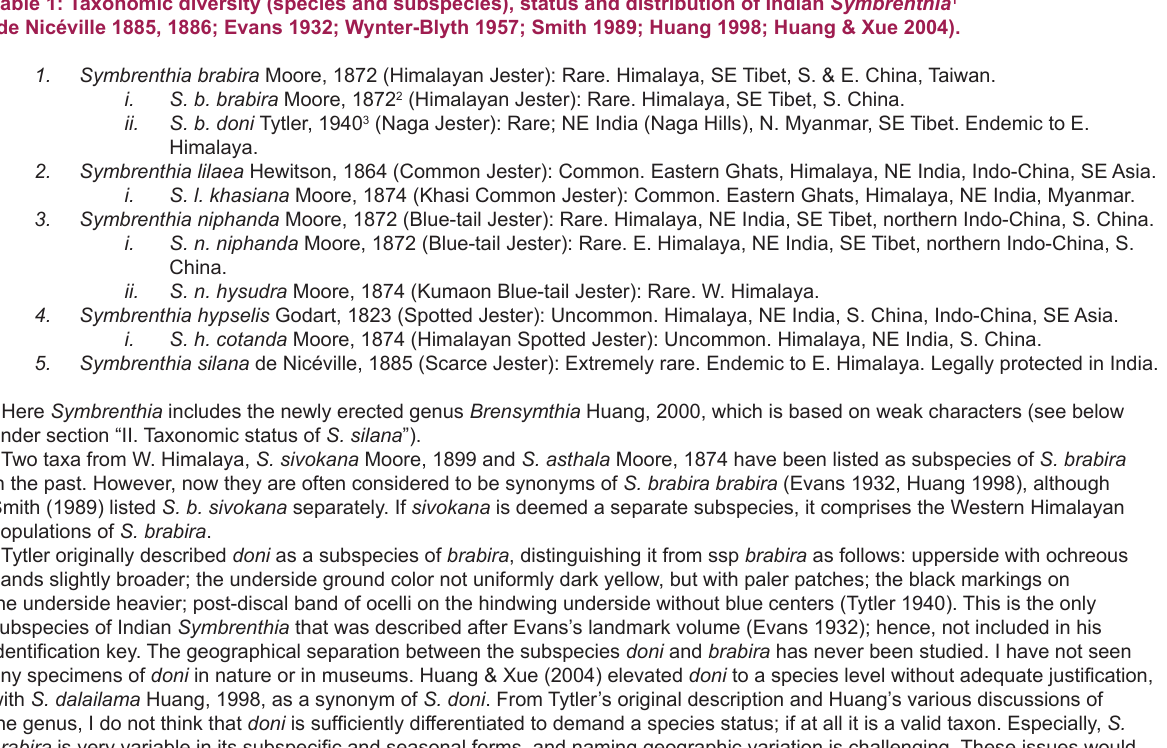
Table 1: Taxonomic diversity (species and subspecies), status and distribution of Indian Symbrenthia 1 (de Nicéville 1885, 1886; Evans 1932; Wynter-Blyth 1957; Smith 1989; Huang 1998; Huang & Xue 2004).